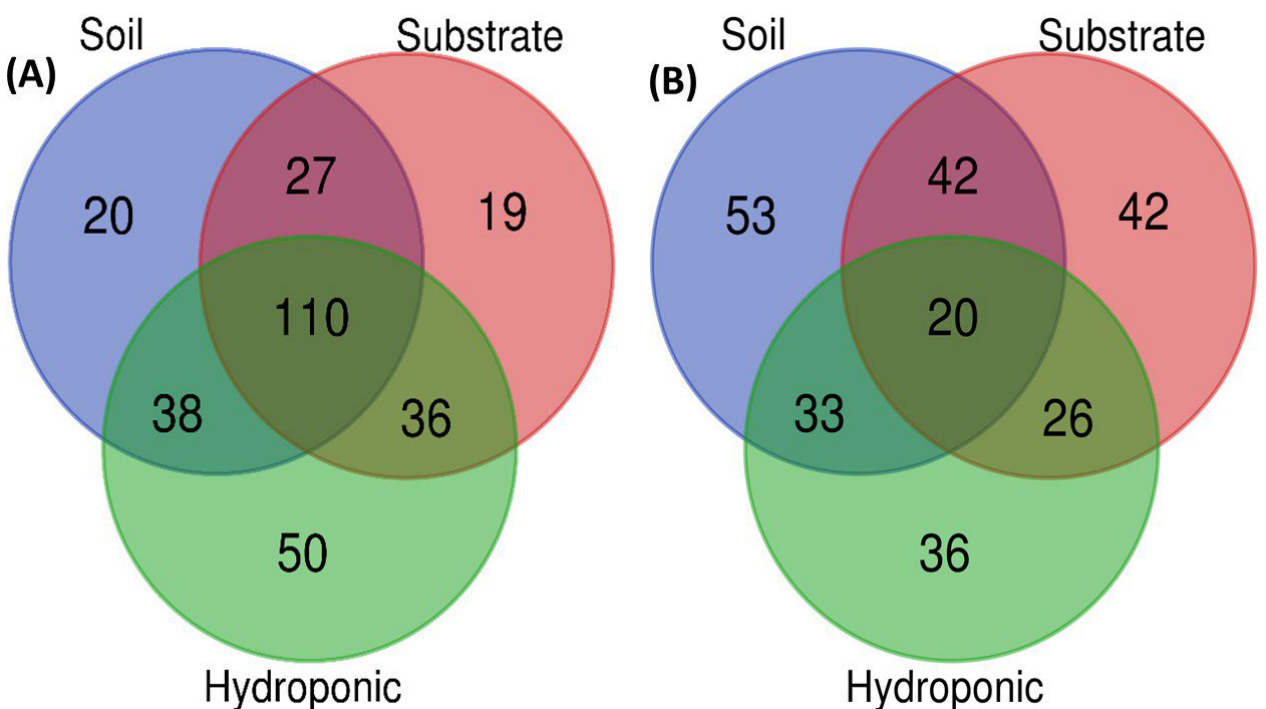
Figure 10. Venn diagrams of lettuce metabolites in soil, substrate and hydroponic cultivation sys- tems using GC-MS and UPLC VION IMS QTOF-MS/MS analysis. Note- Figure ( A ) Similar and dif- ferent metabolites in metabolomic profiling of lettuce in soil, substrate and hydroponic cultivation systems using GC-MS analysis; Figure ( B ) similar and different metabolites in metabolomic profiles of lettuce in soil, substrate and hydroponic cultivation systems using UPLC VION IMS QTOF- MS/MS analysis.